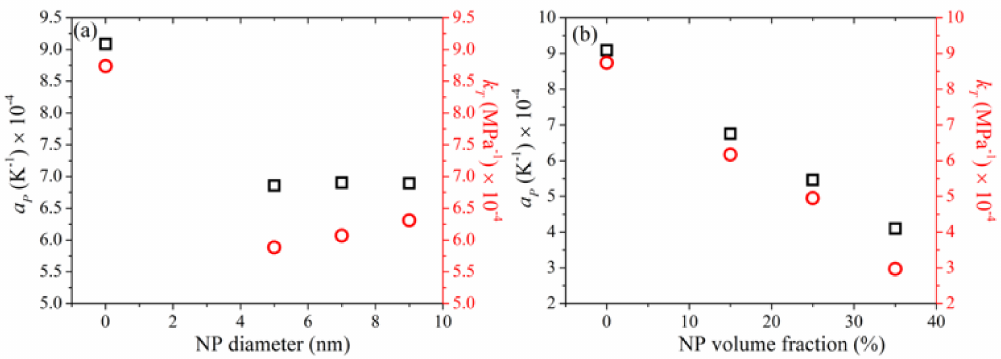
Figure 16. MD predictions for the thermal expansion coefficient a P (black color) and isothermal compressibility k T (red color) of the simulated nanocomposites, and dependence on nanoparticle size ( a ), and nanoparticle volume fraction ( b